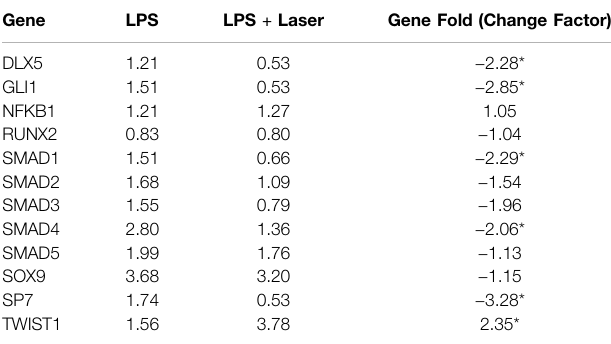
TABLE 5 | mRNA expression of transcription factors in the DPSCs before and after laser